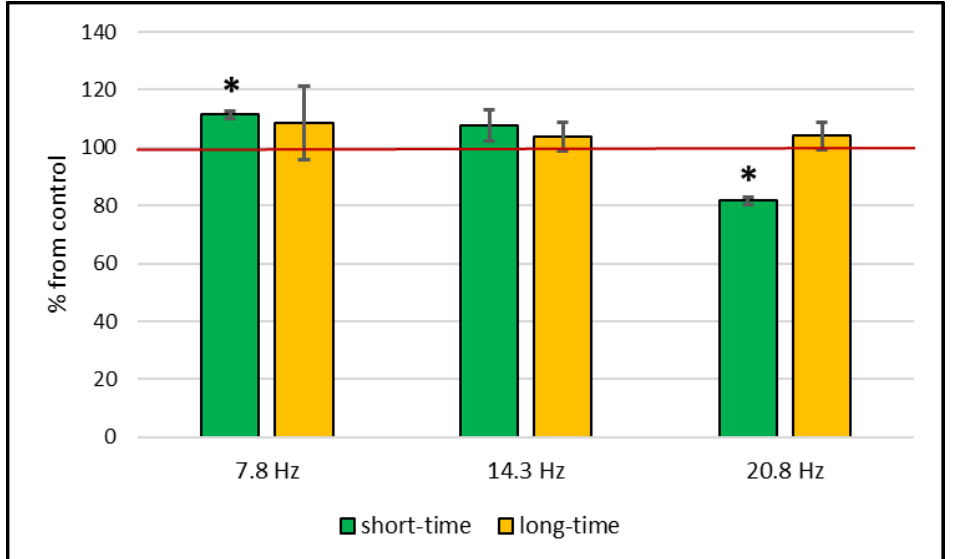
Figure 5. Effect of short-time (30 min) and long-time (18 days) ELF EMF of different frequencies on the content of malondialdehyde in wheat plants; Data are represented as mean ± SD. *—a statistically significant difference from control ( p ≤ 0.05); control level taken as 100%.